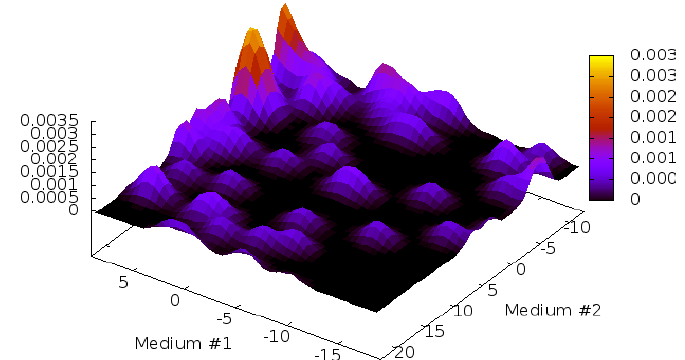
Figure 11. An example of a 2D-PDP map generated using kernel density estimation. This 2D-PDP can serve as a structural